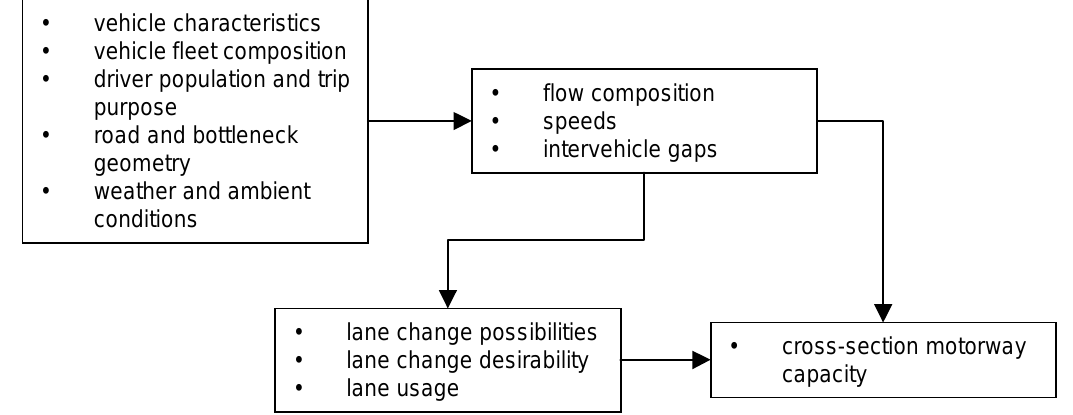
Figure 2. Factors determining changes in road